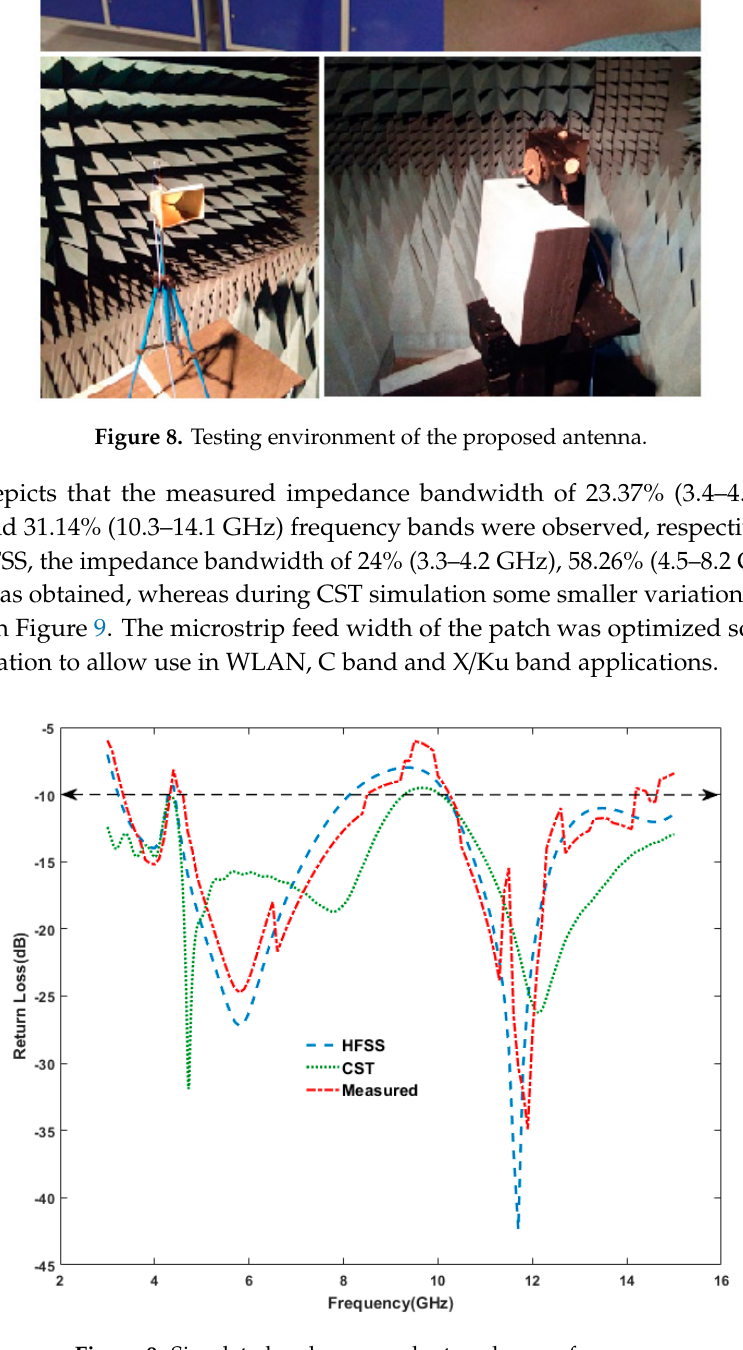
Figure 9. Simulated and measured return loss performance.